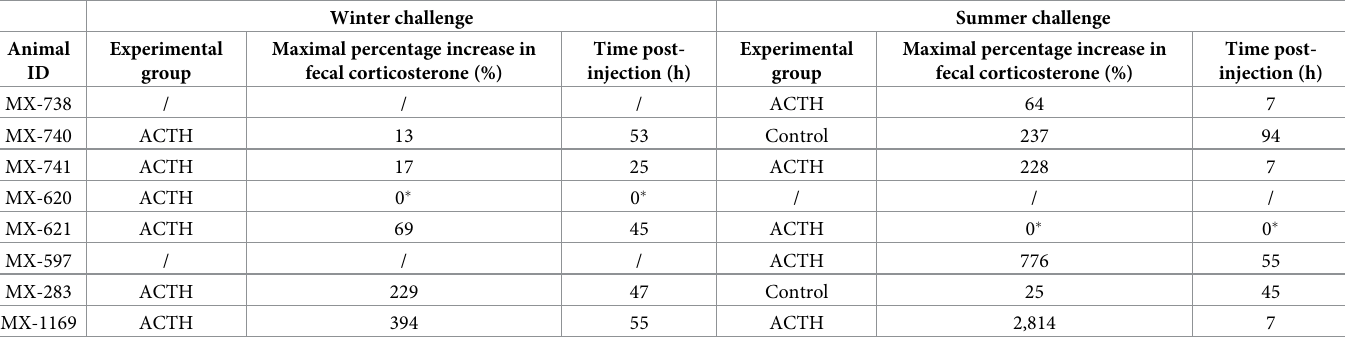
Table 2. Maximal percentage increase in fecal corticosterone as compared to time 0 levels for the muskoxen given a single injection of ACTH (1 IU/kg) during the winter and/or a single injection of ACTH (2 IU/kg) or saline (control) during the summer, and the respective times post-injection at which it was observed. Winter challenge Summer challenge Animal Experimental Maximal percentage increase in Time post- Experimental Maximal percentage increase in Time post- ID group fecal corticosterone (%) injection (h) group fecal corticosterone (%) injection